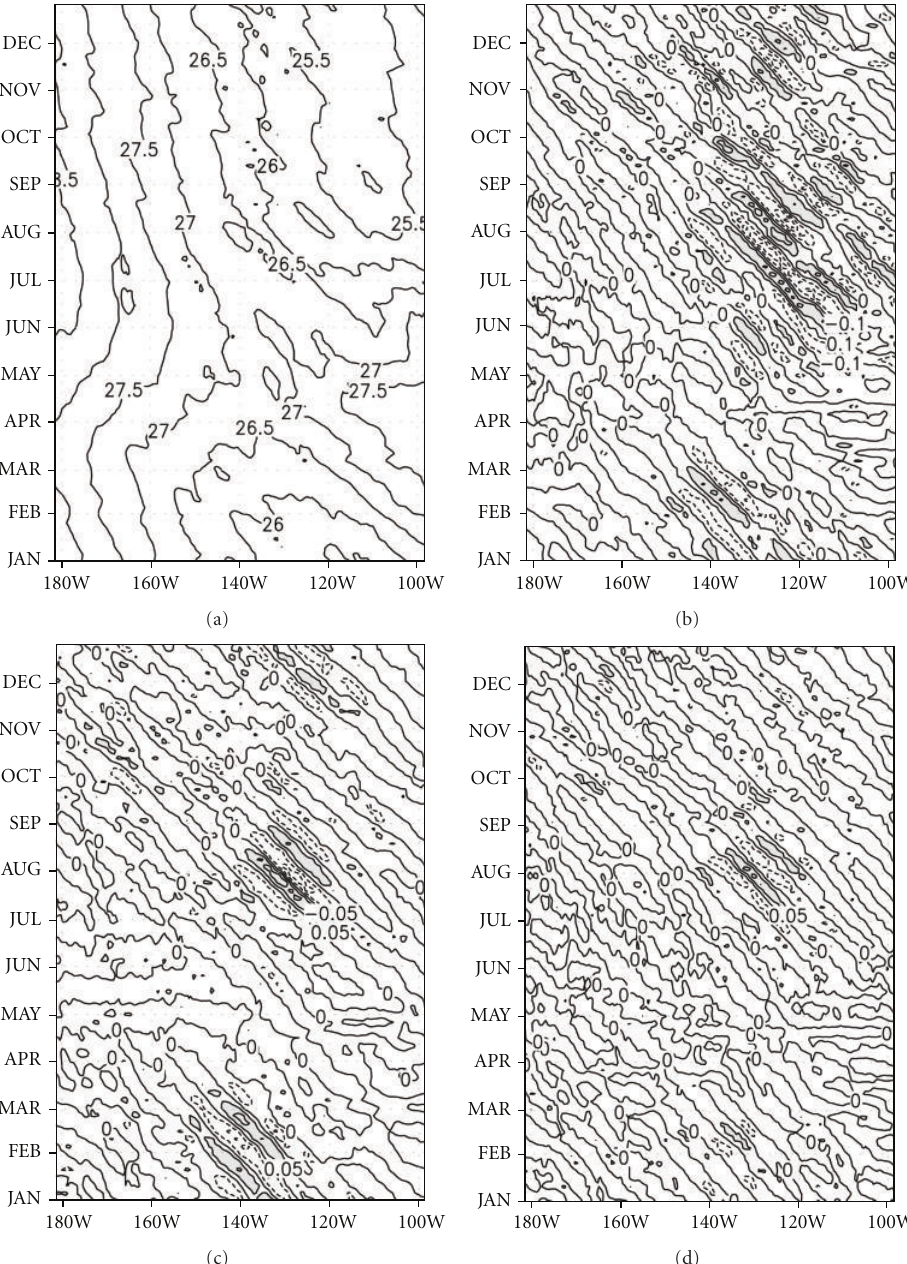
Figure 2: Longitude-time plot of the 50-year climatological-mean (1998–2007) at 2 ◦ N for (a) SST [ ◦ C] and 50-day high-pass filtered (b) temperature [ ◦ C], (c) zonal current [m/s], and (d) meridional current [m/s].